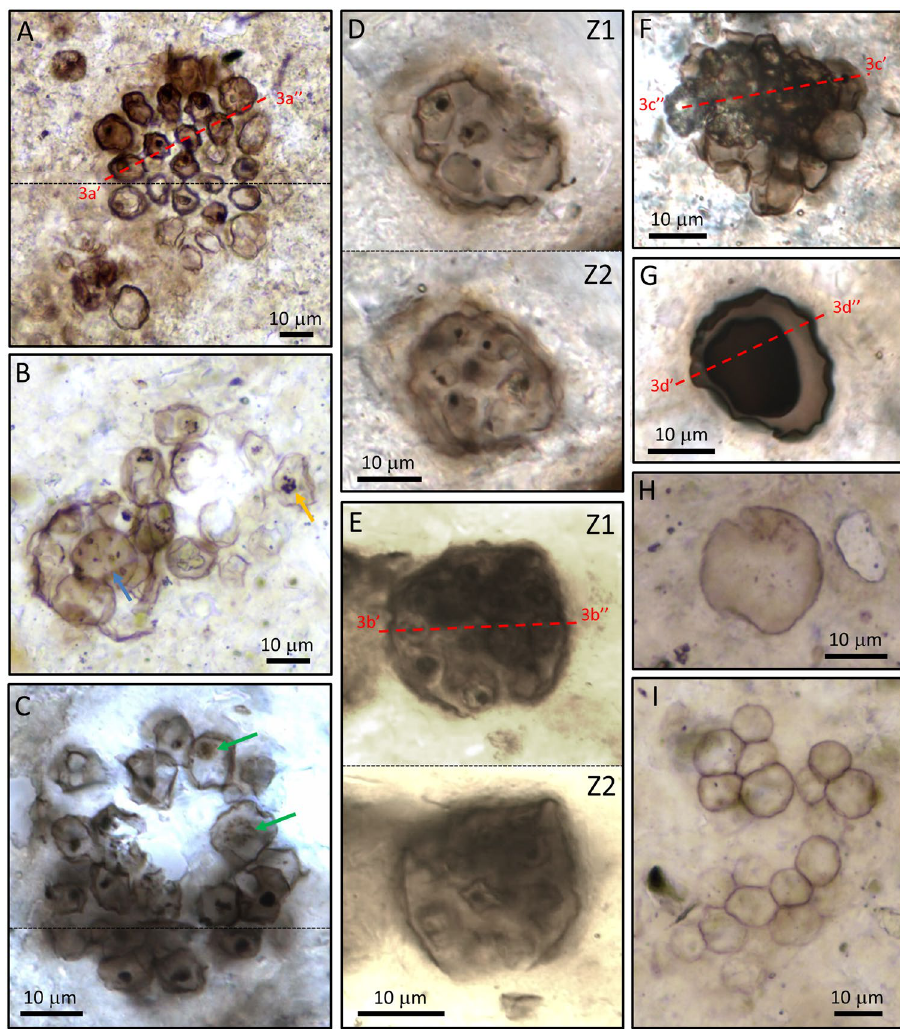
Figure 2. Studied microfossils from the Cailleach Head Formation. ( A – C ) Open clusters of cells, probably Glenobotrydion aenigmatis Schopf. In ( A ) most cells in the cluster contain single dense, medial, organic intracellular inclusions (ICIs). In ( B ) ICIs are not typically single spots, but instead are dispersed throughout the cell (blue arrow) or occur as smaller internal clusters (orange arrow). In ( C ) the ICIs range from dense condensed spots to larger beaded spheroids (green arrows). ( D – E ) Enclosed clusters of small coccoidal cells with ICIs photographed in 2 focal plans, Z1, Z2. Phylogenetic affinity of these is indeterminate. ( F ) Dense cell cluster of unknown affinity with ICIs in a small number of cells. ( G ) Single probably encysted eukaryotic cell of unknown affinity with thick outer (vegetative) cell wall and an inner broadly spherical (cyst?) body. ( H ) Coccoid unicell of unknown affinity possessing a rather thin cell wall. ( I ) Cluster of coccoid cells with mutually adpressed walls that do not contain ICIs. REE phosphates have been observed in the cell types depicted in ( A – G ) but not in the cell types depicted in ( H , I